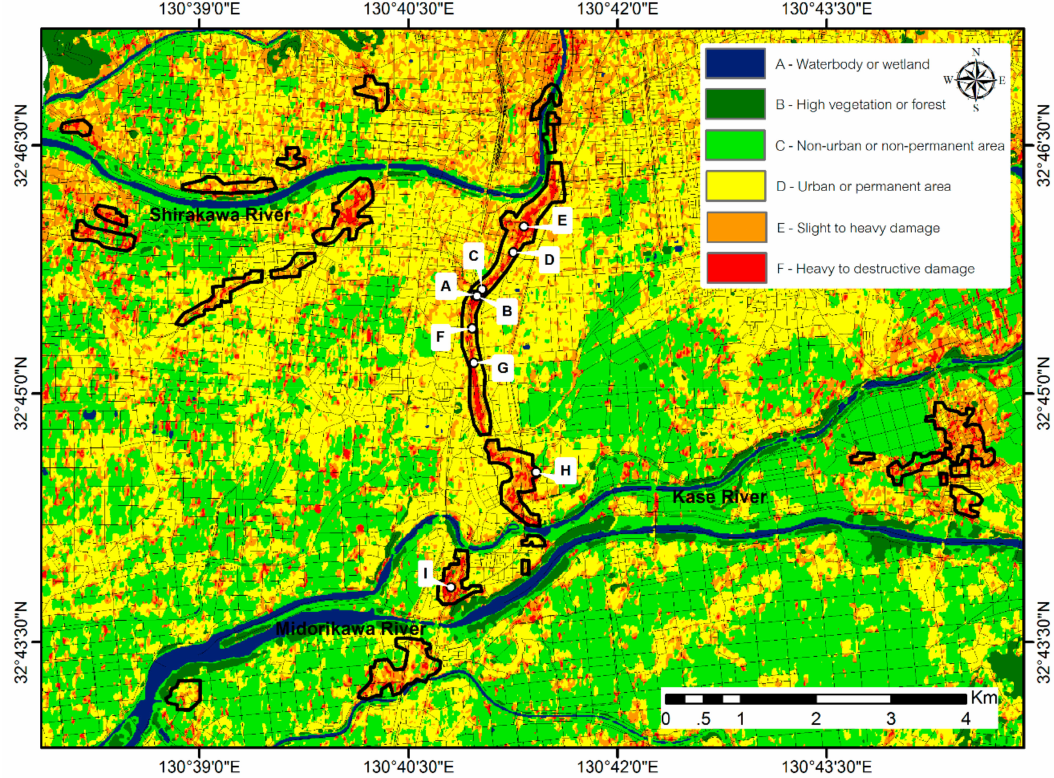
Figure 8. Liquefaction map obtained through analysis and liquefaction areas from the JGS and JSCE survey (black